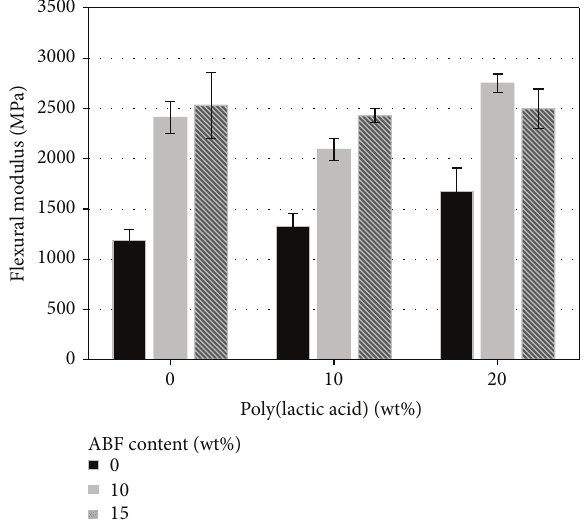
Figure 8: Flexural modulus of polymer blends and composites at 25 ∘ C, varying PLA